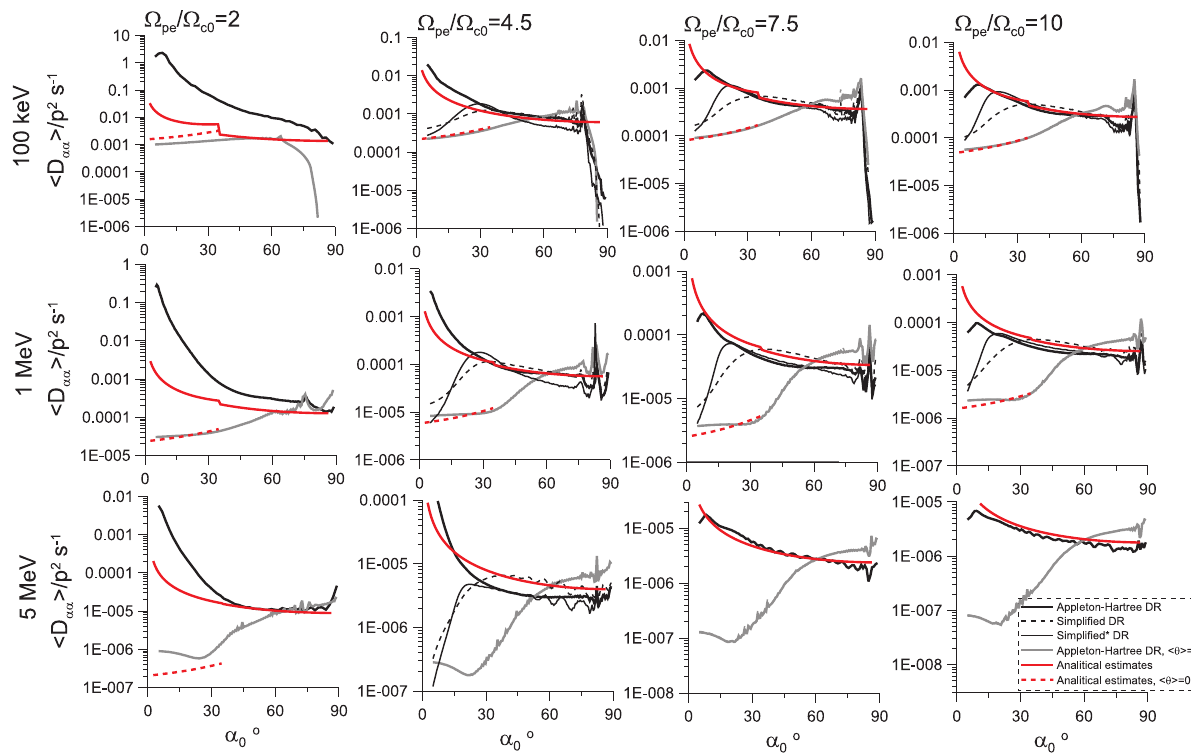
Fig. 8. h D αα i for three values of electron energy and four values of the ratio (cid:127) pe /(cid:127) c0 , for quasi-parallel and oblique chorus waves. Full numerical solutions as well as the corresponding analytical estimates in Eqs. (4) and (6) are displayed.